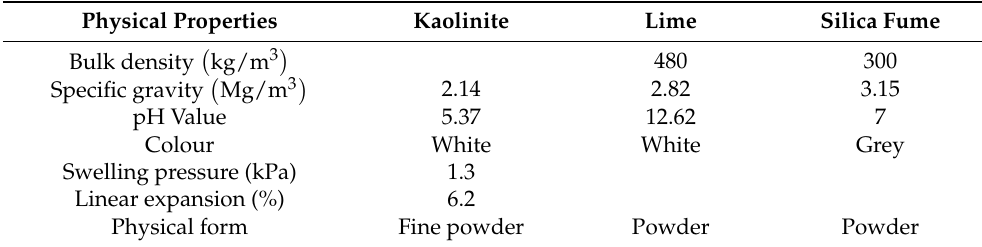
Table 2. Physical properties of kaolinite, lime, and silica